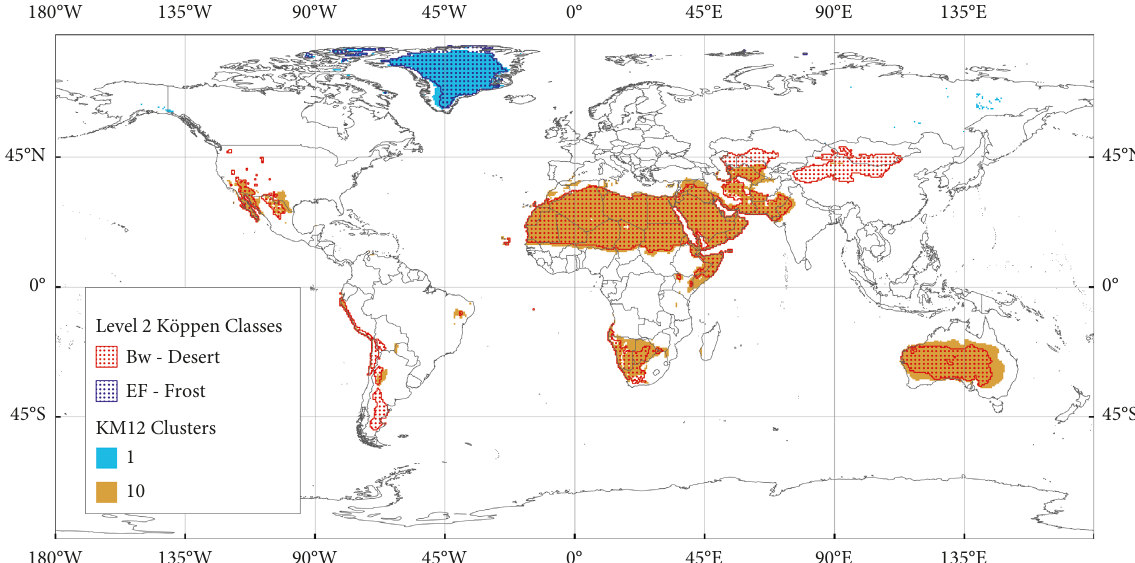
Figure 11: K¨oppen classes and k -means clusters with the highest similarity. There are clusters in k -means 12-cluster results that closely resemble the EF polar climate and the Bwh desert climate. Cold desert regions of the Bwh class have been excluded from the corresponding k -means cluster.